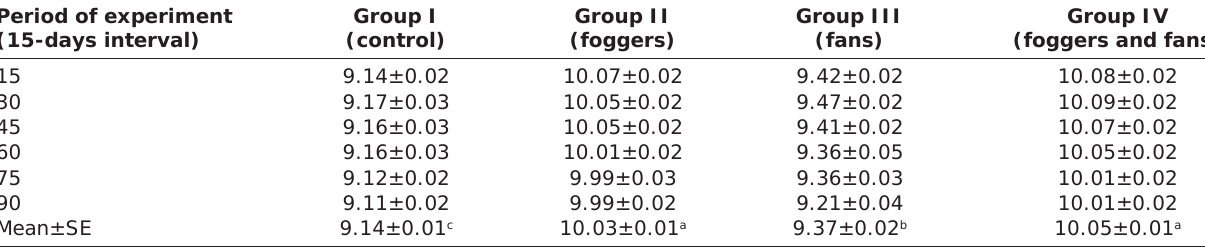
Table-11: Effect of microclimate alteration on milk SNF (%) in Murrah buffaloes during summer. Period of experiment (15-days interval)